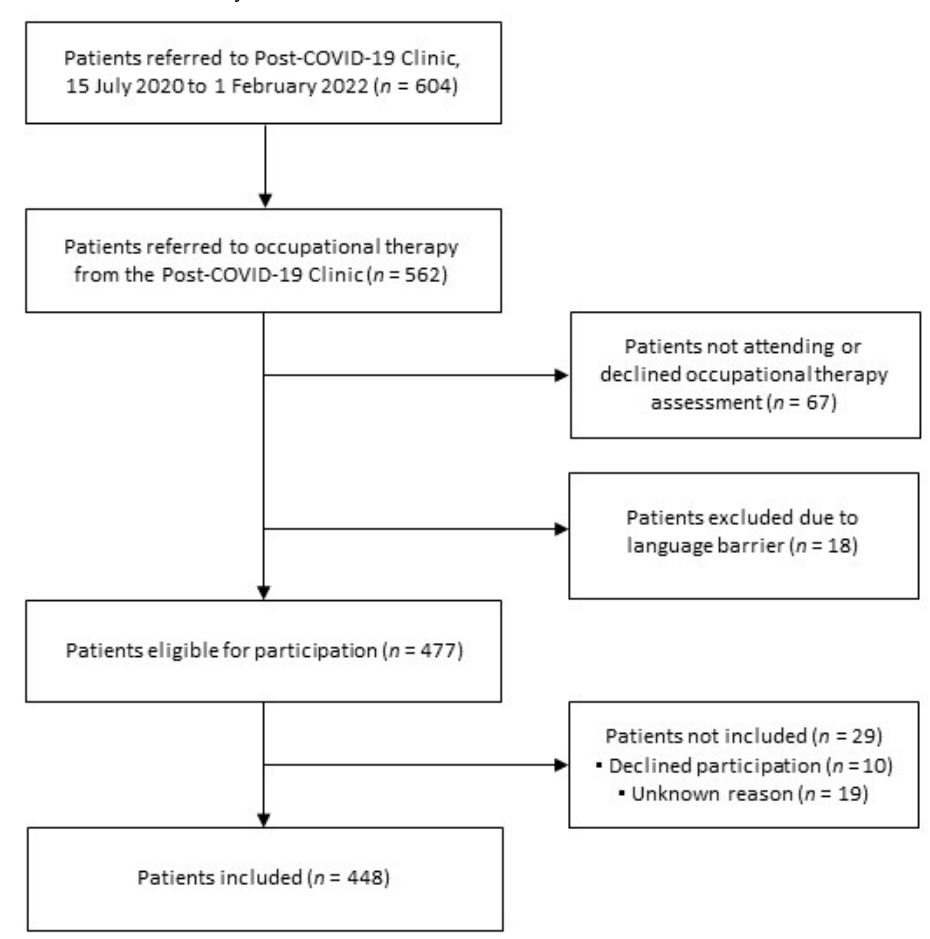
Figure 1. Flowchart of the participants showing the inclusion and exclusion